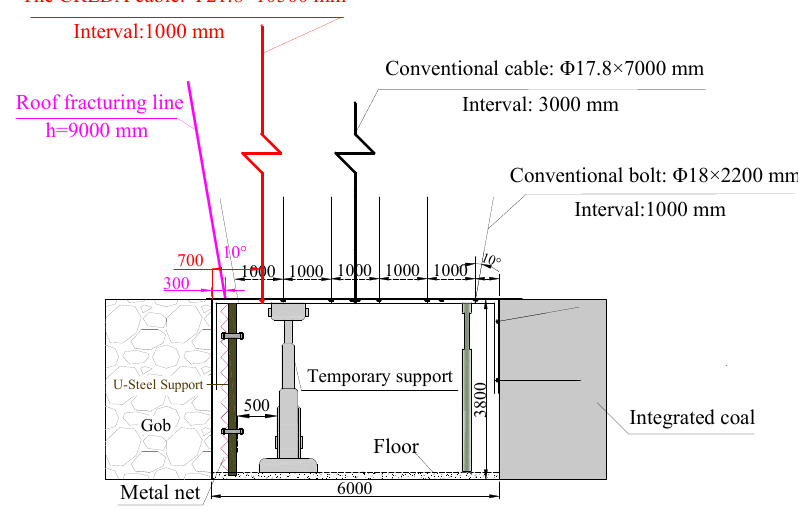
Figure 13. Entry-in support design.